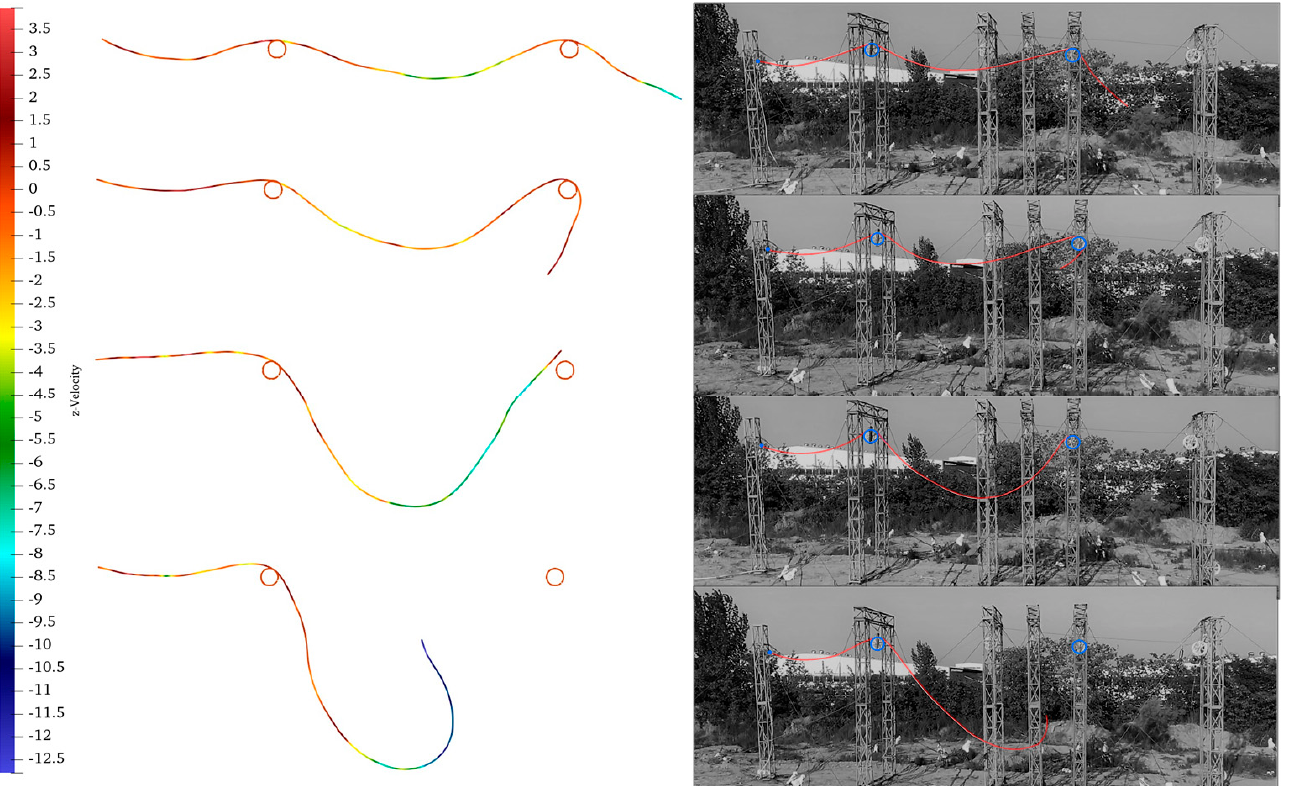
Figure 11. Comparison of the simulation and experimental results.